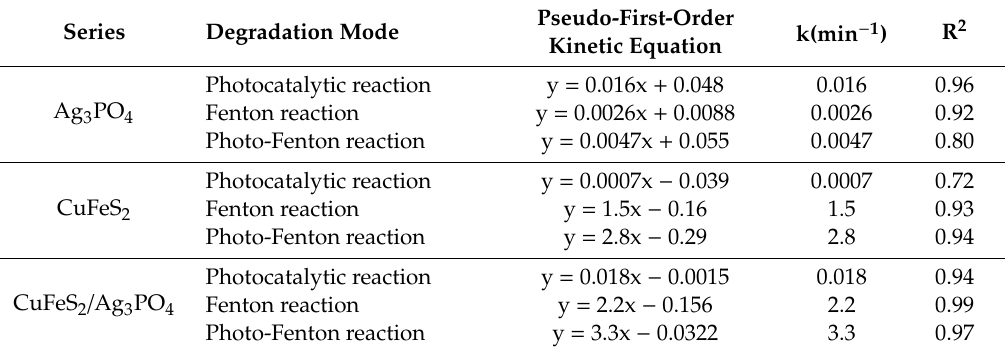
Table 1. Pseudo-first-order rate constants for rhodamine B (RhB) degradation by Ag 3 PO 4 , CuFeS 2 ,